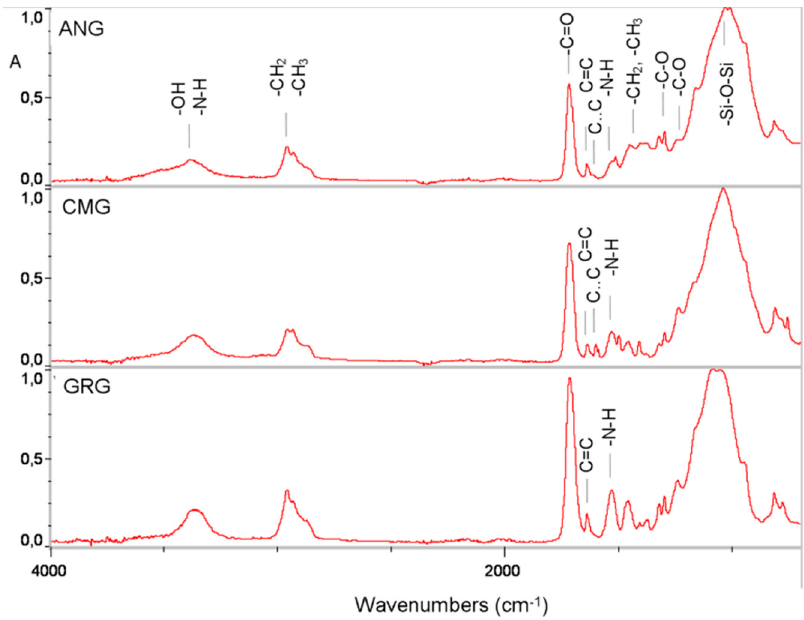
Figure 1. ATR-FTIR absorbance spectra of the unset materials.